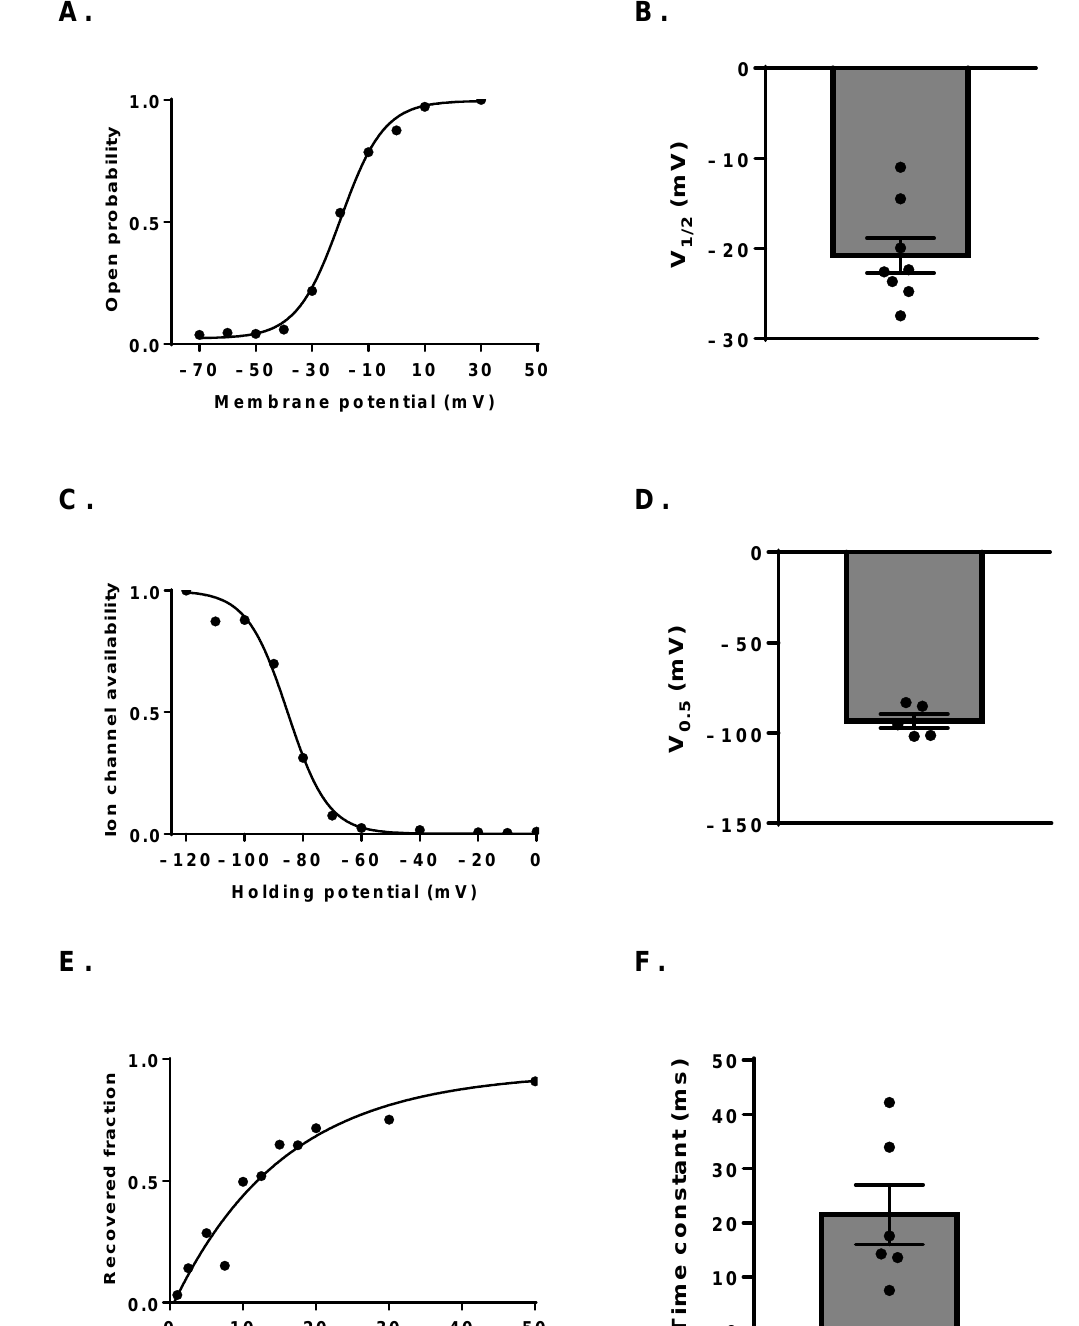
Figure 2. Biophysical characteristics of Na V channels expressed in B cells. ( A ) A representative G-V curve from an individual cell. ( B ) Half-maximal activation potentials of the individual cells determined from G-V curves. ( C ) Voltage-dependence of the steady-state inactivation of a representative cell determined by depolarizing pulses to 0 mV from the indicated holding potentials. ( D ) Half-inactivation potentials determined from SSI curves. ( E ) Kinetics of the recovery from inactivation of a representative cell determined by depolarizing pulse pairs to 0 mV separated by various recovery time intervals ( ∆ t) at − 100 mV. ( F ) Summary of the recovery time constants. Throughout the figures, bar heights indicate mean ± SEM and the black symbols represent data obtained from individual